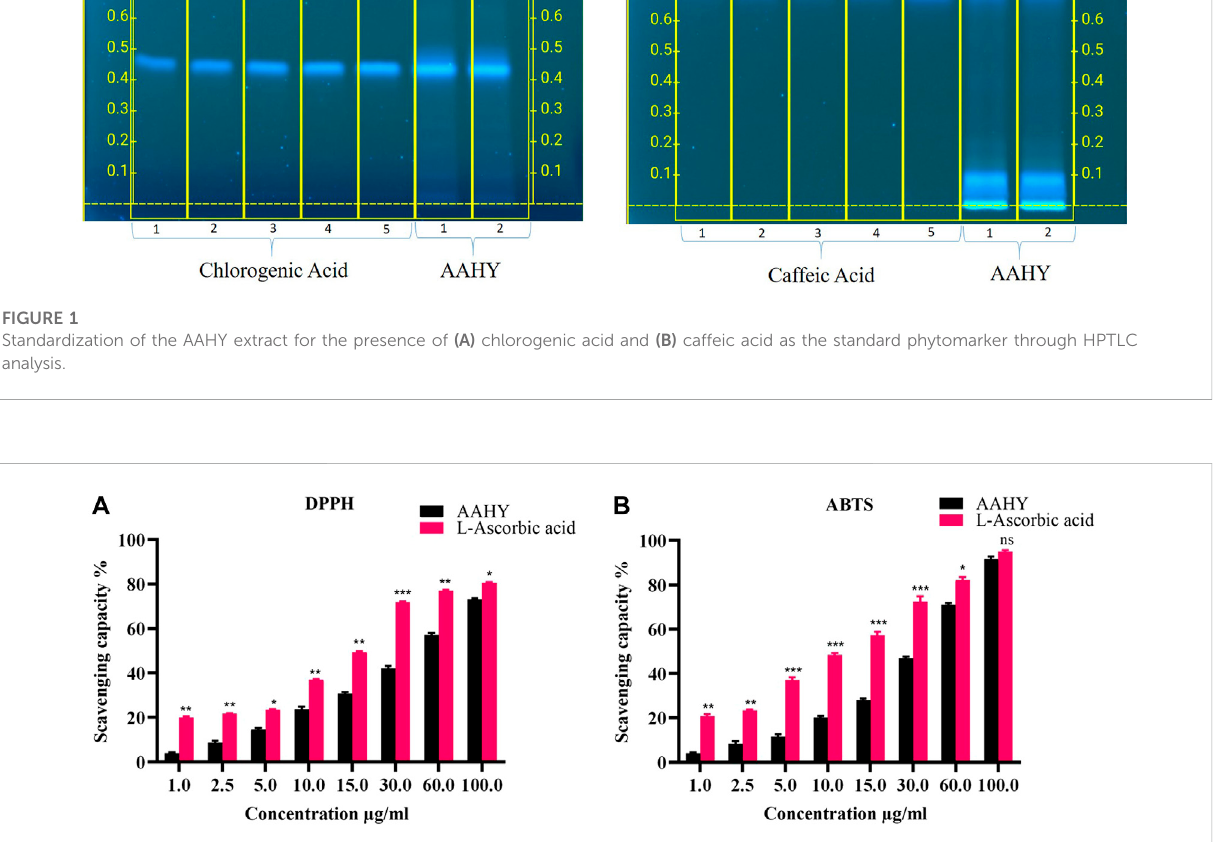
FIGURE 2 (A) DPPH and (B) ABTS free radical scavenging activities (%). A comparison of different concentrations of the AAHY extract and ascorbic acid is shown. Data are represented as mean ± SEM, and experiments were performed thrice ( n = 3). * p < 0.05, ** p < 0.01, and *** p < 0.001 versus the AAHY extract. SEM: standard error of